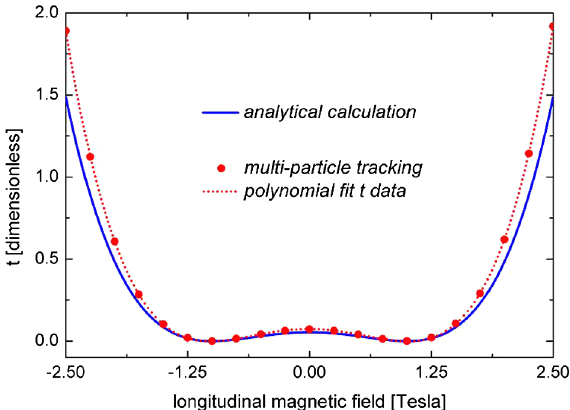
FIG. 5. The parameter t calculated analytically and by multi- particle tracking simulation. Although the longitudinal magnetic field is varied, the decoupling gradients are kept constant at the values determined to decouple the beam coupled by a longitu- dinal magnetic field of 1.0